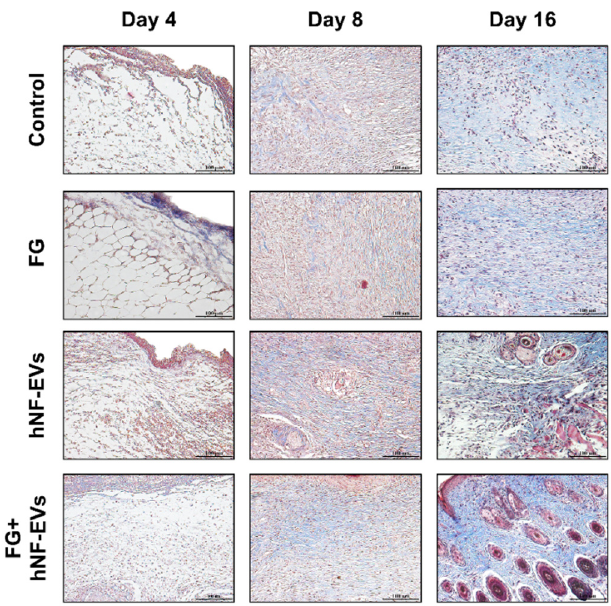
Figure 8. hNF-EVs accelerate collagen deposition and maturity in the wound. Masson’s trichome staining of wound sections in controls: FG, hNF-EV, and FG + hNF-EV groups (day 4, 8, and 16), (scale bar = 100 µm).